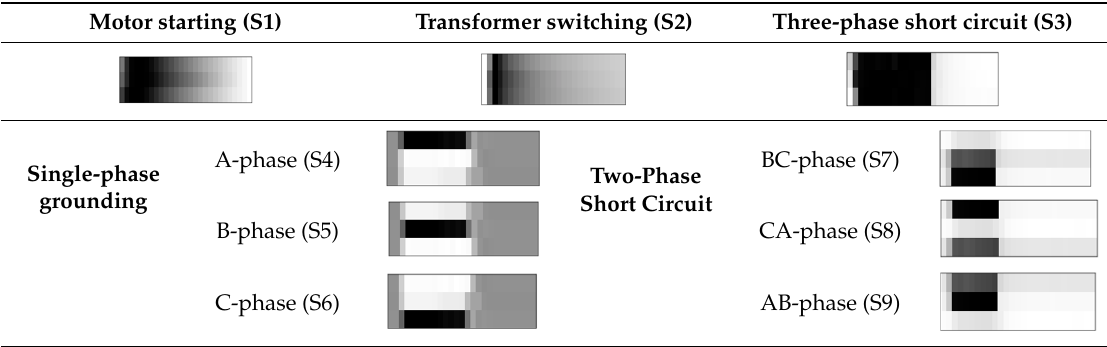
Table 2. Grayscale image of voltage sag category.